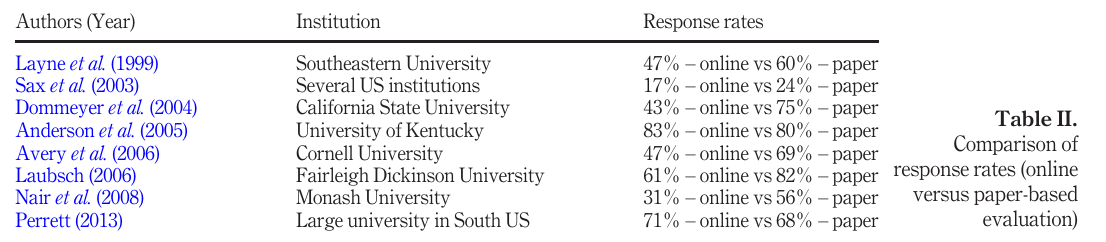
Table II. Comparison of response rates (online versus